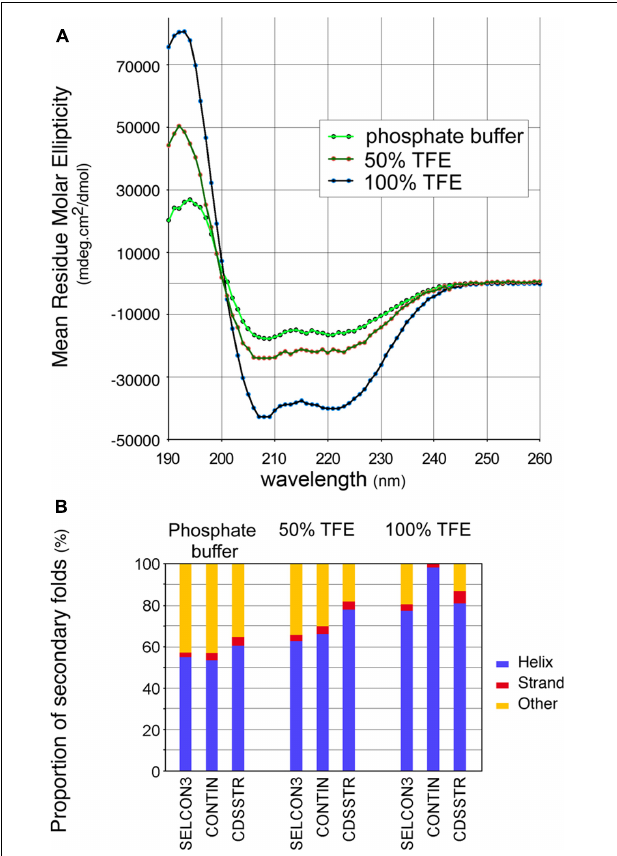
FIGURE 5 | Circular dichroism (CD) spectra of a synthetic peptide confirms the helical conformation of the CTD. (A) CD spectra of a synthetic peptide corresponding to residues 374–410 were recorded in aqueous phosphate buffer, in semihydrophobic (50% TFE), and hydrophobic (100% TFE) environments. Each spectrum corresponds to the average of 10 acquisitions. (B) Estimated distribution of secondary folds in the synthetic peptide in the different environments assayed, using the deconvolution algorithms SELCON3, CONTIN and CDSSTR from the Dichroweb server (Whitmore and Wallace,